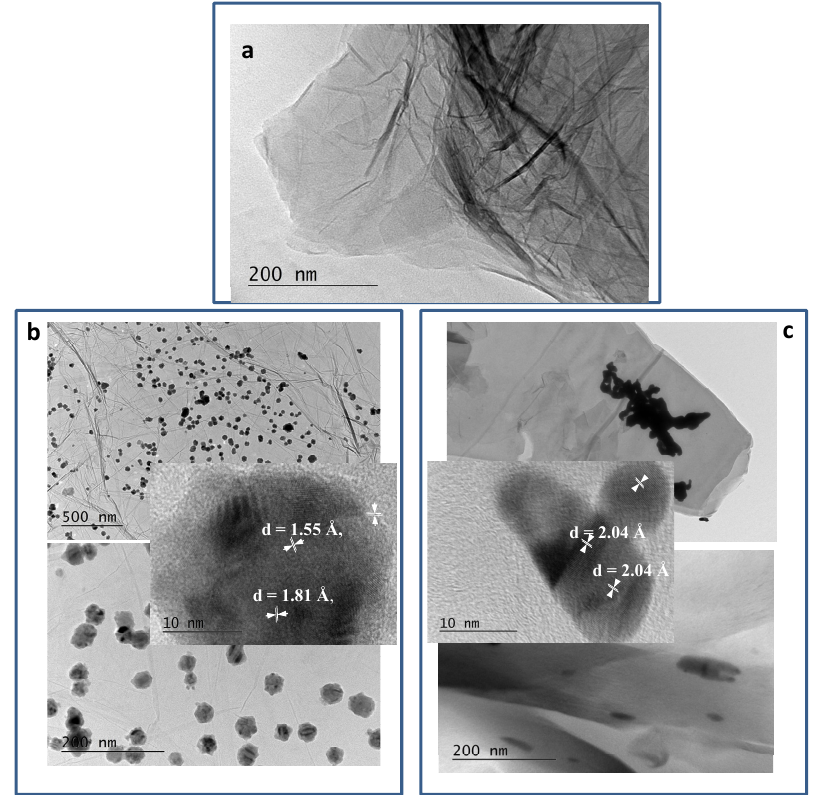
Figure 3. TEM images of: ( a ) RGO, ( b ) Cu–RGO/Cu, ( c )